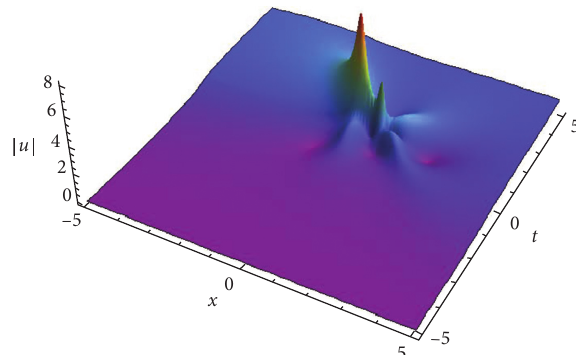
Figure 15: Asymmetric second-order fractional rogue wave (color online) with α � 5/6 and a � 1 modified from solution